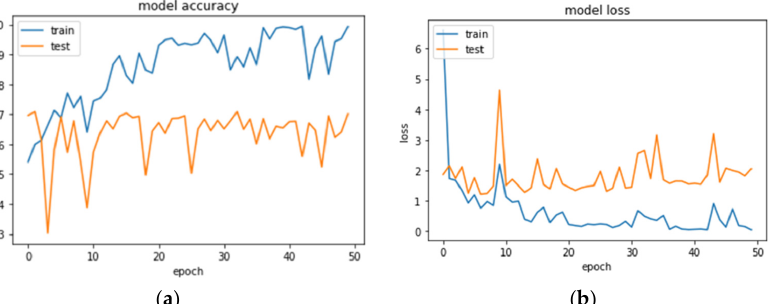
Figure 16. Training and testing of MLP model: ( a ) training and testing accuracy, ( b ) training and testing loss.